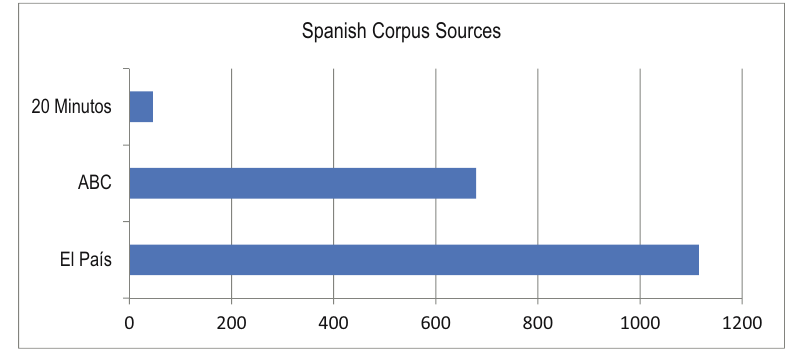
Figure 4: Number of pieces of each of the newspapers forming the Spanish corpus.